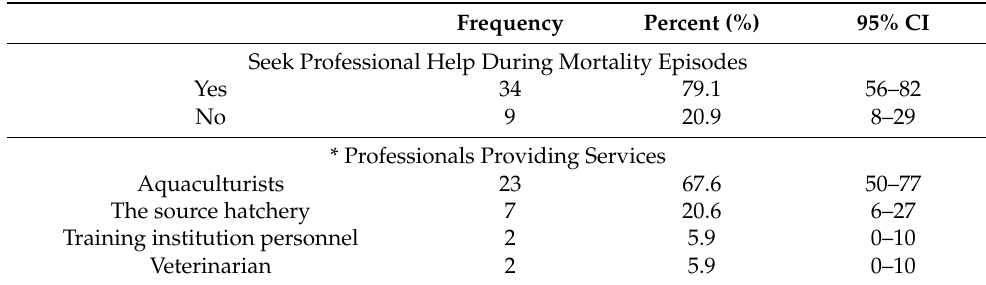
Table 5. Fish health diagnostic and extension